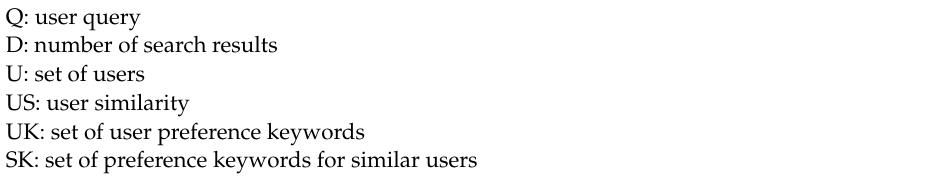
Algorithm 1: Fractional-cascading method-based ranking